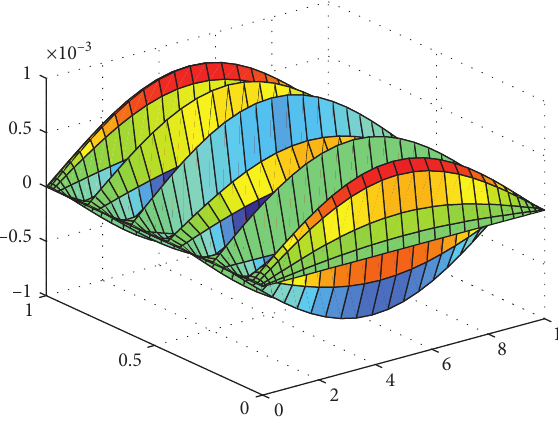
Figure 5: Errors of deflection with quasi-equidistant nodes m � n � 28.